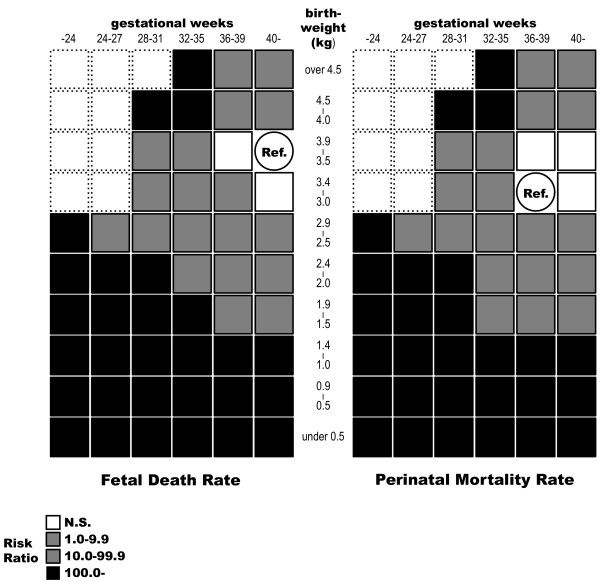
Single/lowest single risk ratio. The risk ratio for each birth weight and gestational week category is shown. Birth weight and gestational weeks category for the lowest mortality is a reference with a risk ratio of 1.0.